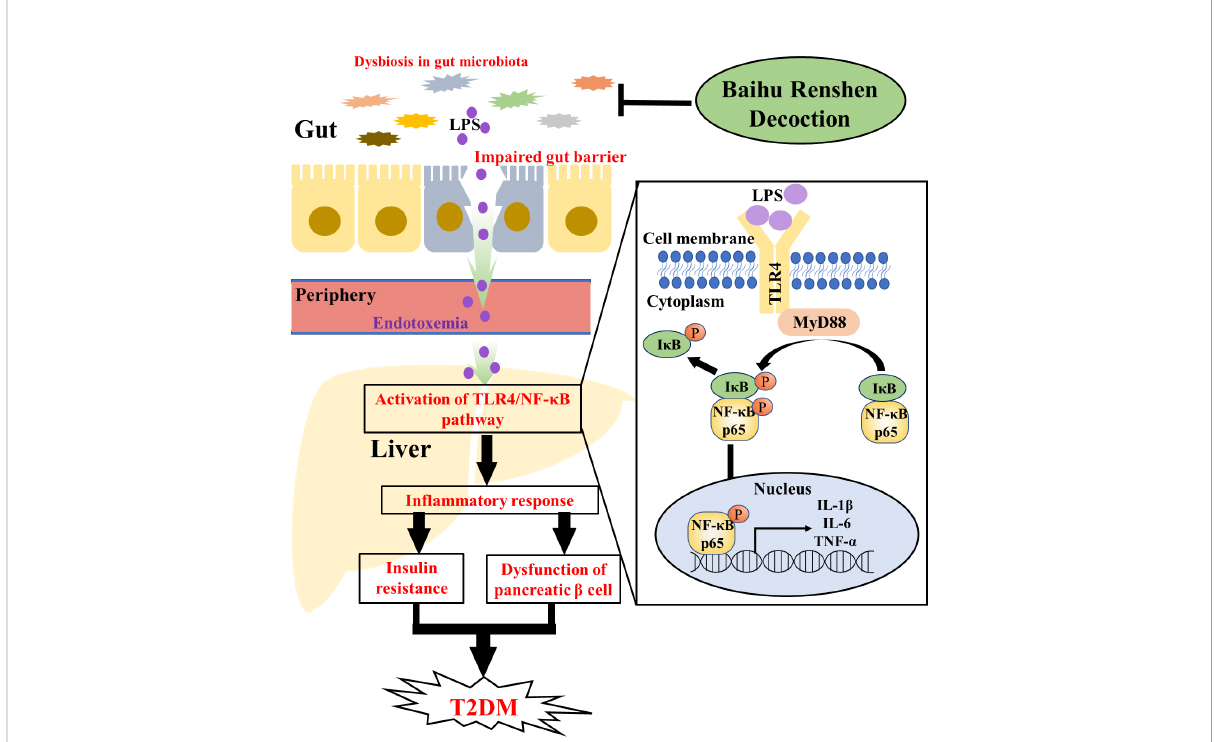
FIGURE 6 Graphcal abstract. The dysfunction in gut microbiota could impair the tight junction of gut epithelial cells. Then, the LPS of gut microbiota could enter periphery through lack gut barrier and cause endotoxemia. After entering the periphery, LPS could induce in fl ammatory response in liver through the TLR4/NF- k B pathway [ (1) TLR4 in cellular membrane is activated after bind with LPS; (2) Activated TLR4 recruited MyD88 in cytoplasma to form a TLR4-MyD88 complex; (3) TLR4-MyD88 complex induced the phosphorylation of I k B and NF- k Bp65; (4) Phosphorylated NF- k Bp65 entered the nucleus and induced the transcription of pro-in fl ammatory factors such as IL-1 b , IL-6 and TNF- a , whereas phosphorylated I k B was degraded in cytoplasma]. The in fl ammatory response in liver and the released cytokines could contribute to the progression of T2DM through inducing the insulin resistance and the dysfunction of pancreatic b cell. BHRS treatment ameliorated T2DM through regulating the dysbiosis of gut microbiota, enhancing the gut permeability and inhibiting the activation of TLR4/NF- k B